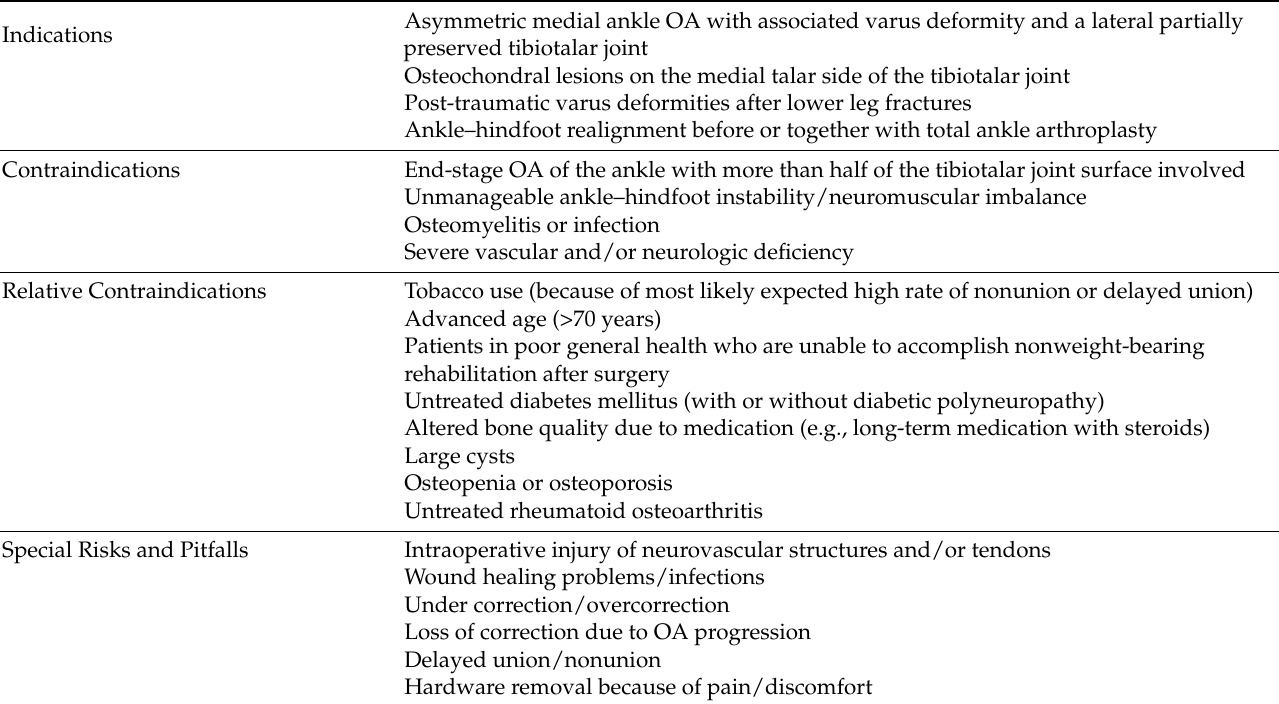
Table 2. Indications, Contraindications, Special risks, and Pitfalls for Joint-Preserving Surgery of Asymmetric Varus Ankle Osteoarthritis